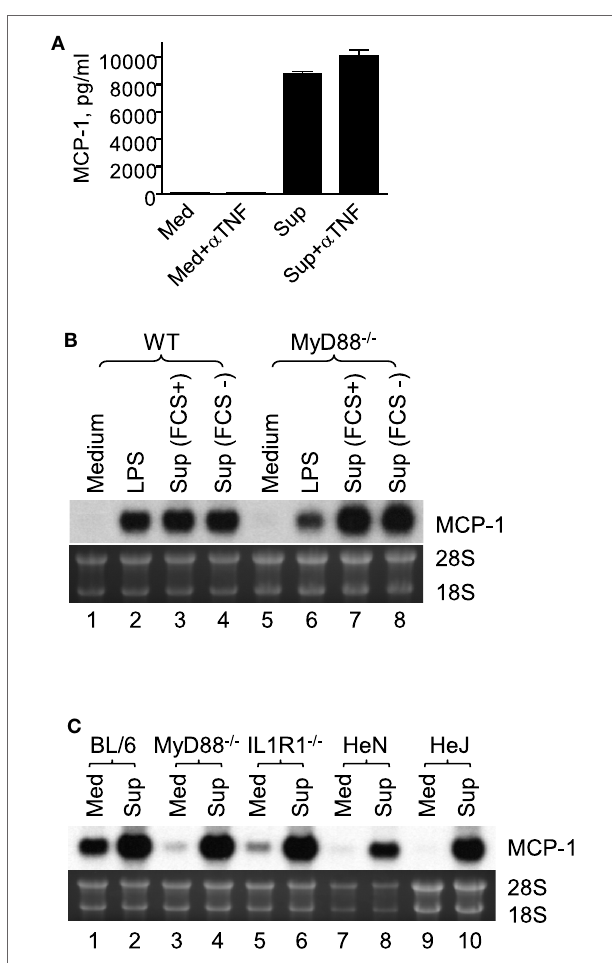
FigUre 2 | Macrophage production of McP-1 in response to stimulation by 4T1 supernatant is independent of TnF α , il-1r1, Tlr4, or MyD88. (a) Five million WT TG-induced PEC were incubated in the presence or absence of 4T1-sup (1:1) or 10 ng/ml TNF α for 24 h and the concentration of MCP-1 in cell-free culture supernatants was measured by ELISA. To neutralize TNF α , 10 μ g neutralizing anti-TNF α IgG was added to the culture. The results are shown as the mean ± SD, n = 2. (B) Two and half million TG-induced PEC from WT or MyD88 − / − mice were cultured for 4 h in the presence of 100 ng/ml LPS or 4T1-sup. Total RNA was isolated and subjected to Northern blotting. (c) Two and half million TG-induced PEC from WT or MyD88 − / − , IL-1R1 − / − , C3H/HeN (TLR4 + / + ), or C3H/HeJ (TLR4 − / − ) mice were cultured for 4 h in the presence of 4T1-sup (1:1). Total RNA was isolated and subjected to Northern